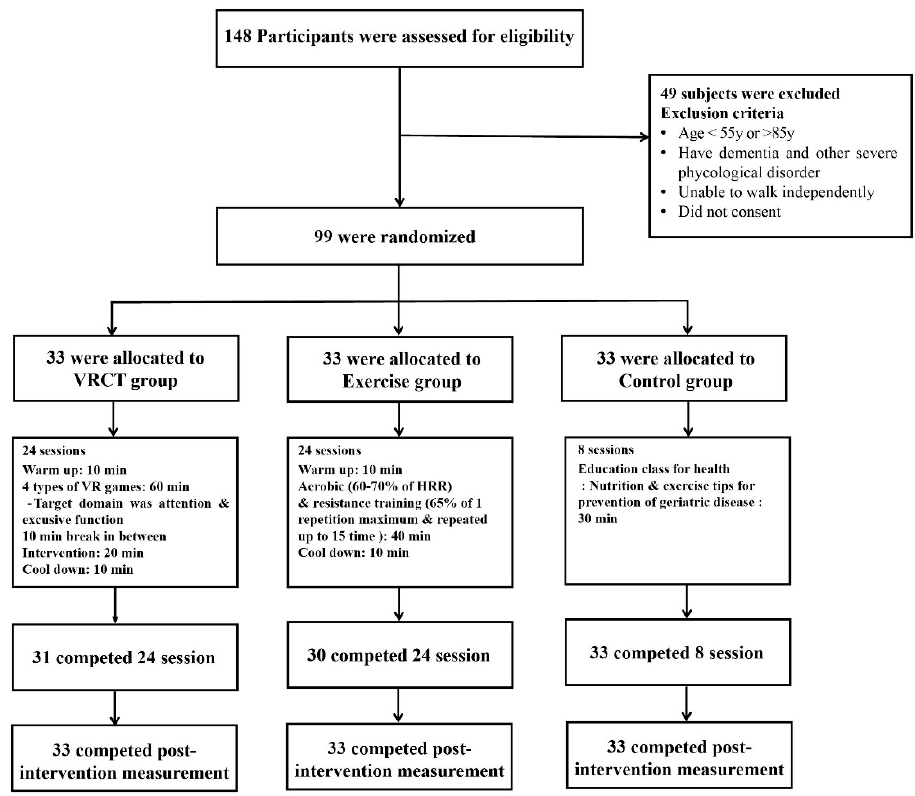
Figure 1. Flow diagram of participants throughout